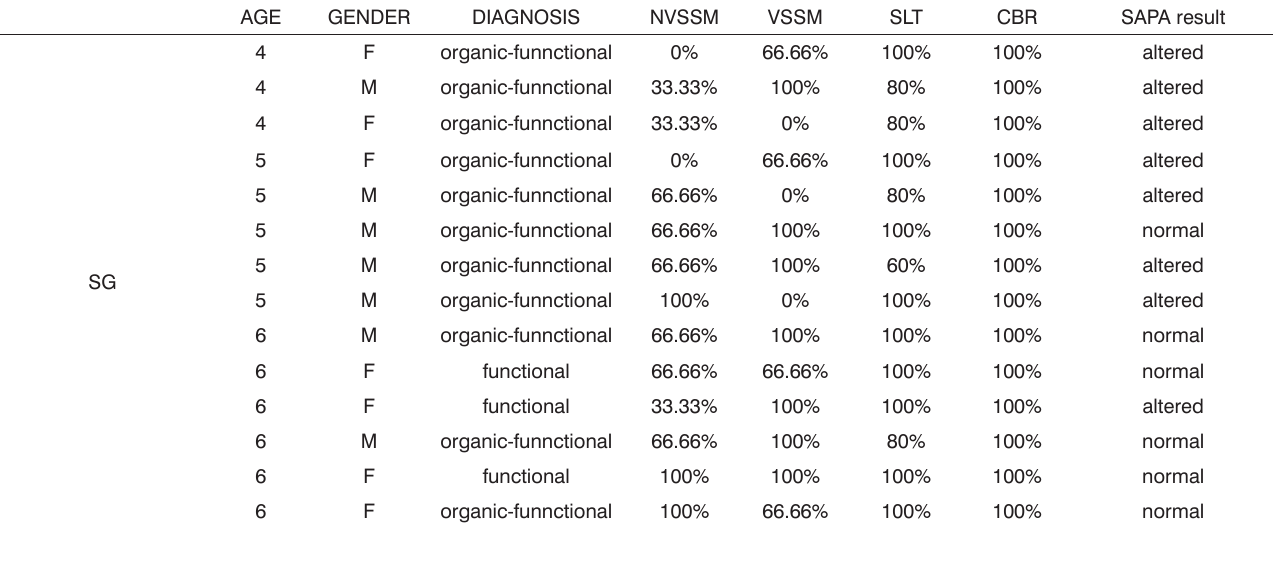
Table 1. SG and CG distribution by gender, age, speech and hearing diagnosis and performance in the Simplified Auditory Pro- cessing